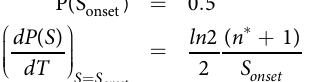
Figure 1. Nucleation probability curves at three different temperatures for seed particle radius = . r nm 3 35 The horizontal dashed line marks the onset condition ( P = 0.5). Arrows point to higher temperature and show both increasing and decreasing S onset with increasing T . Data points from SANC measurements of Kupc et al . 8 Curves are fits to the Gumbel